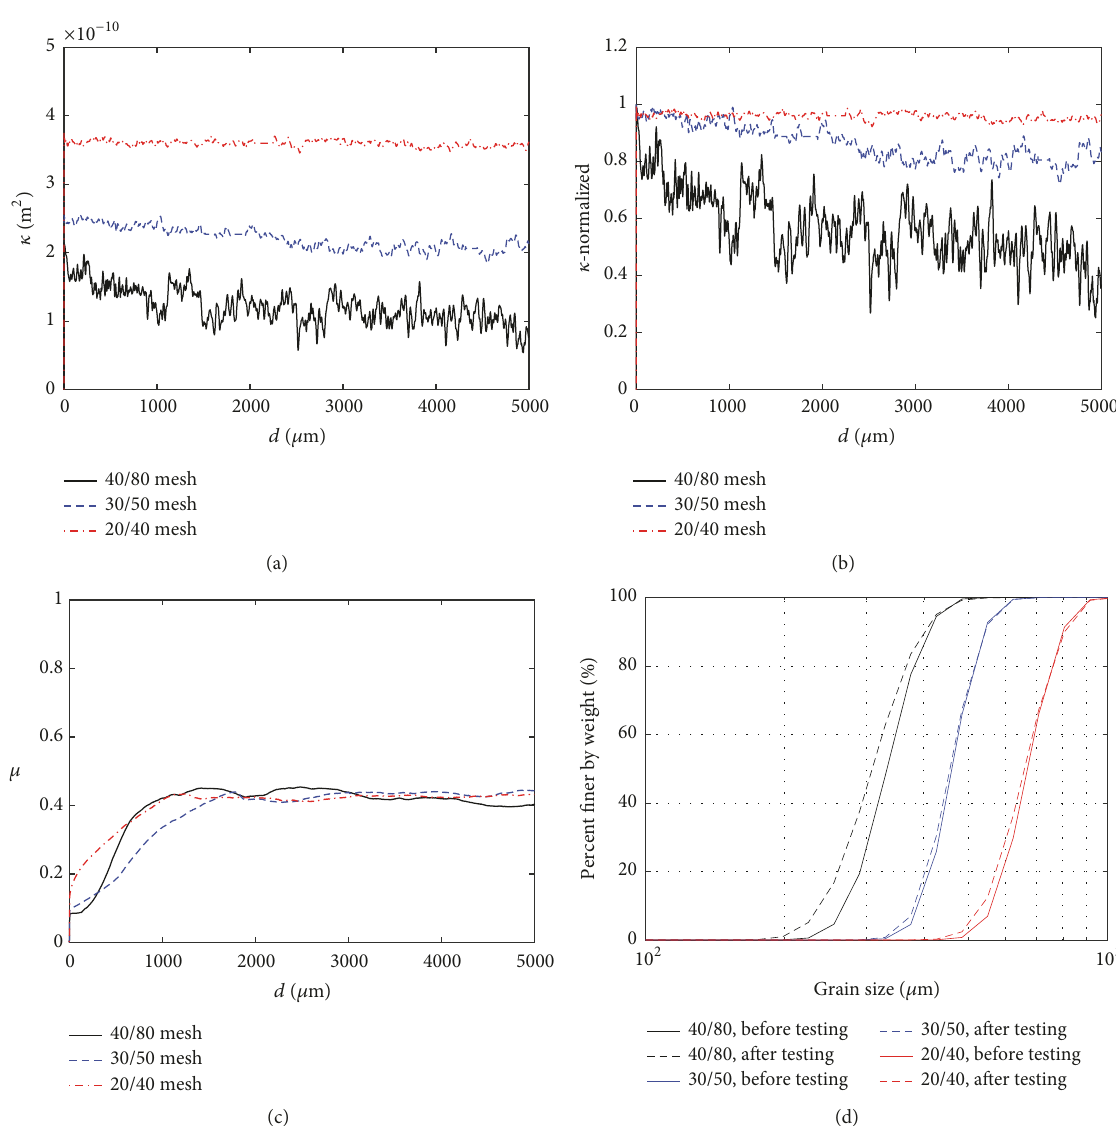
Figure 11: Evolution of (a) permeability, (b) normalized permeability (with respect to the initial permeability value), and (c) friction for the propped fracture during shearing for three different proppant sizes, namely, 40/80 mesh, 30/50 mesh, and 20/40 mesh with displacement; (d) particle size distributions of proppants both before and after shearing. The confining stress is 3 MPa for all